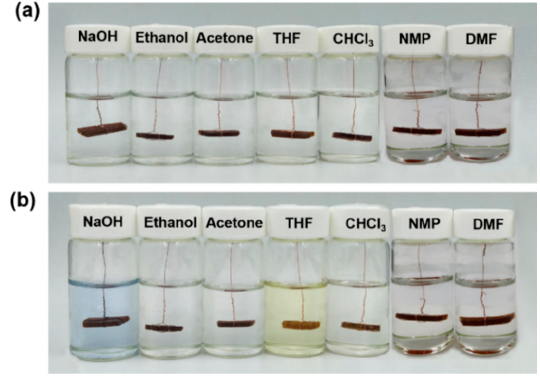
Figure 6. Photographs of the PHT in different solvents ( a ) before and ( b ) after standing for 120 h at room temperature.